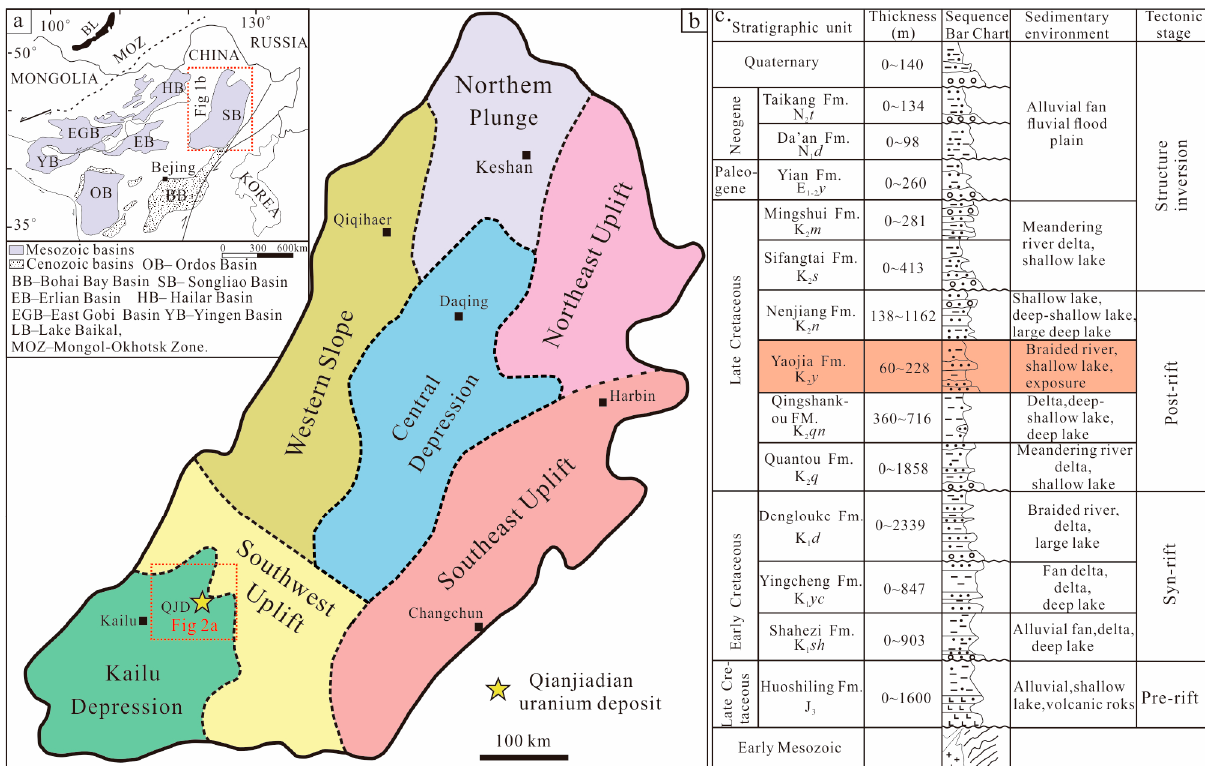
Figure 1. Location ( a ), Tectonic units ( b ) and Stratigraphic column ( c ) of the Songliao Basin (a modified from [33]; b modified from [24]).